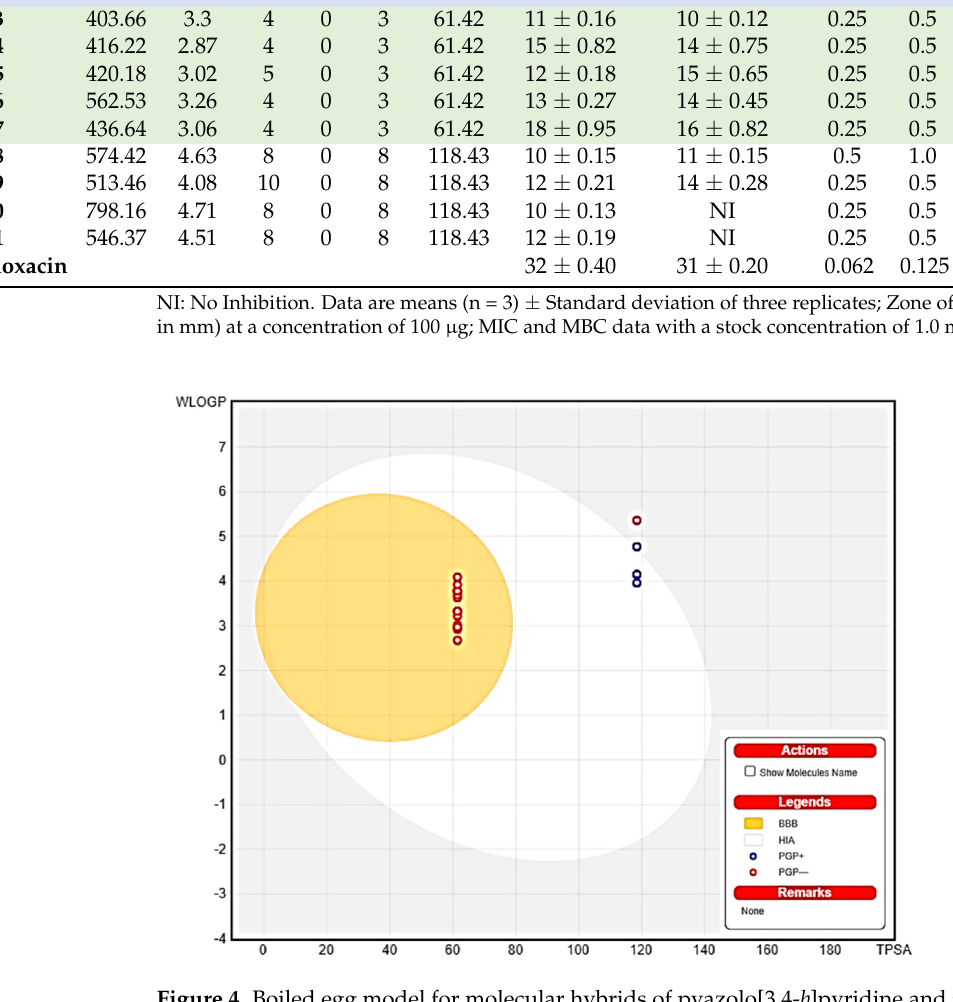
Figure 4. Boiled egg model for molecular hybrids of pyazolo[3,4- b ]pyridine and triazole.